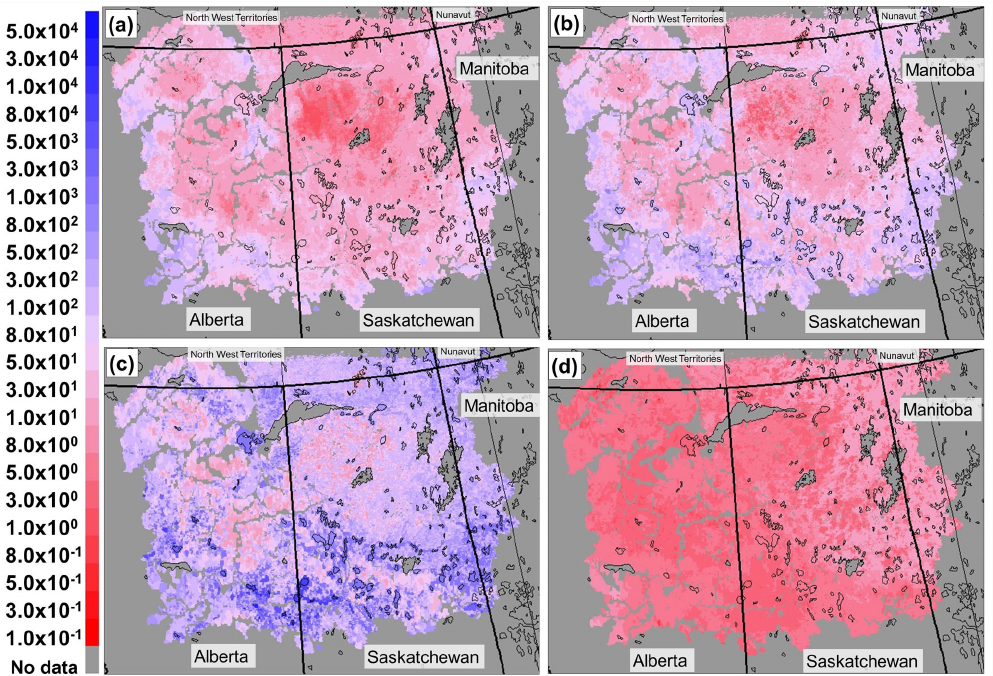
Figure 5. Critical loads of acidity with respect to S dep (CL(A)), and S dep and N dep (FAB model) for aquatic ecosystems (eqha − 1 yr − 1 ). (a) CL(A) (b) CL max (S). (c) CL max (N). (d) CL min (N). No data: data were not collected for the largest lakes and river systems within the coloured region; the boundaries of the coloured region represent the limit of the catchment basins for which data were collected.